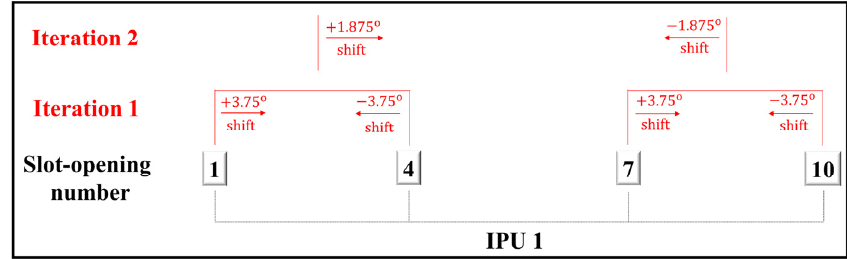
Figure 6. The slot-opening shift angle in an IPU (8P12S).